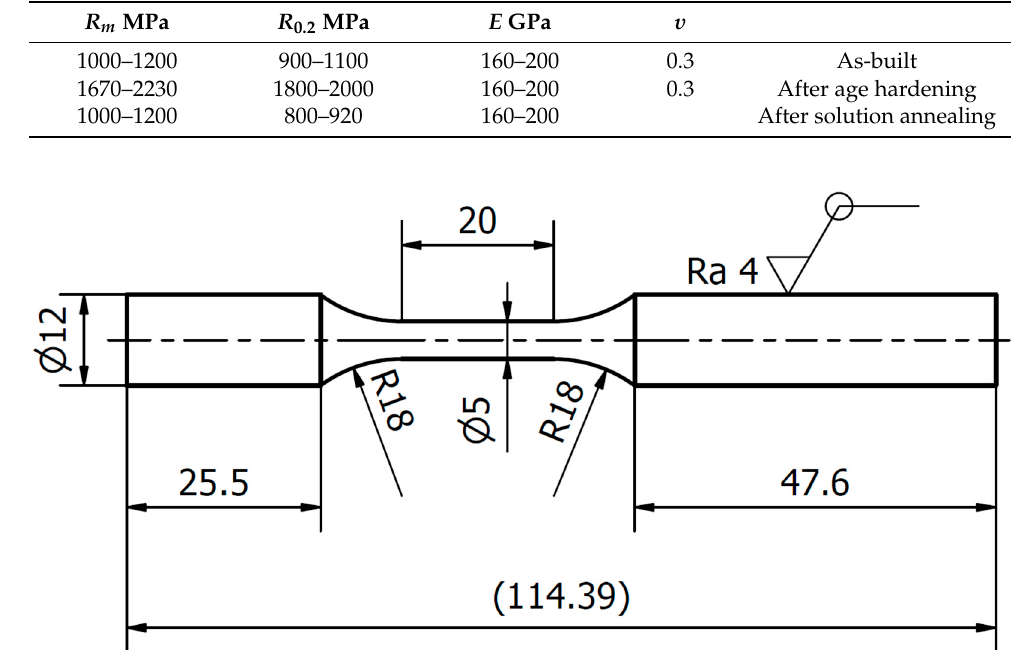
Figure 1. Geometry and dimensions of the specimens used in this experimental research for the tension–compression tests.